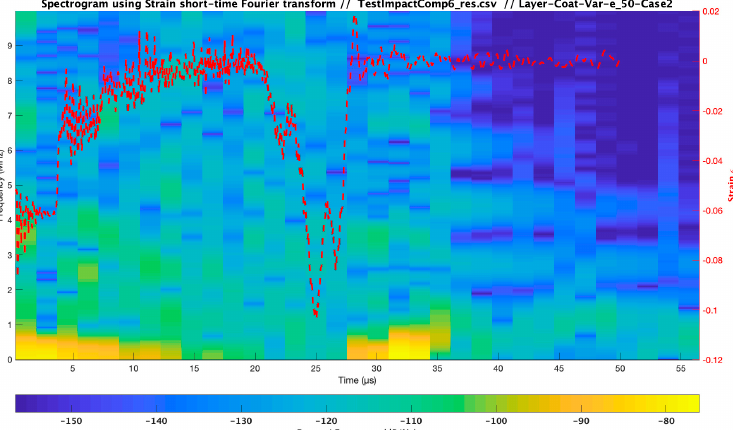
Figure 31. Strain-Time evolution for Cases 1–3 at middle coating layer, 50% thickness, considering the substrate-filler as semi-infinite with variation in droplet diameter.